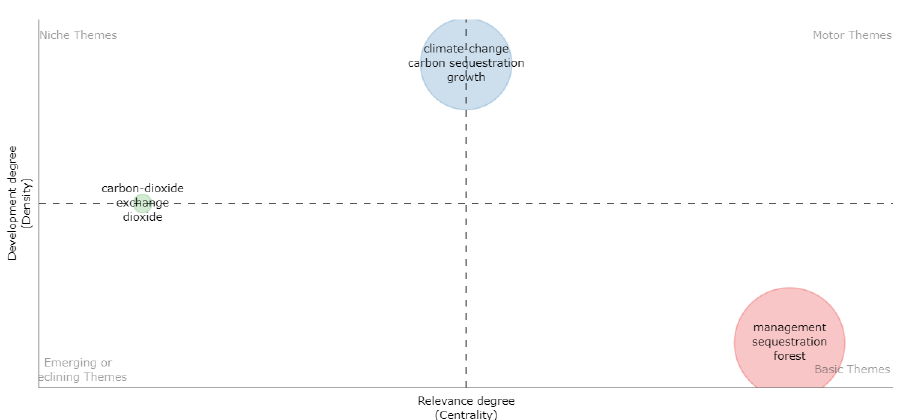
Figure 8. Thematic